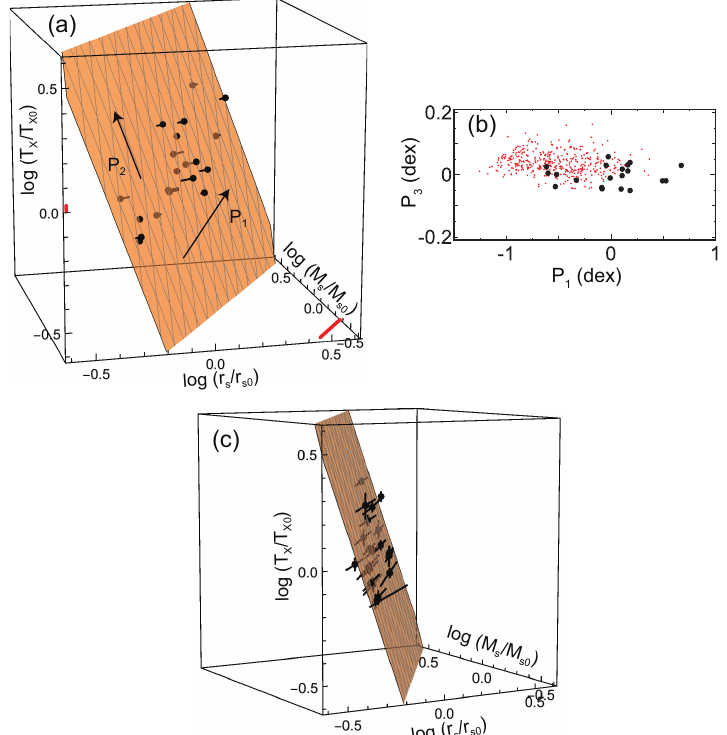
Figure 1. ( a ) Black dots (pin heads) are the CLASH data in the space of ( log ( r s / r s 0 ) , log ( M s / M s 0 ) , log ( T X / T X 0 )) , where r s 0 = 570 kpc, M s 0 = 3.8 × 10 14 M (cid:12) , and T X 0 = 8.2 keV are the sample geometric averages (log means) of r s , M s , and T X , respectively. The orange plane is the best fit of the data. The orange plane is translucent, and the grayish points are located below the plane. The lengths of the pins show the distance to the plane. The red bars show typical 1 σ errors of the data. The arrow P 1 shows the direction to which the data distribution is most extended, and the arrow P 2 is perpendicular to P 1 on the plane. ( b ) The cross-section of the plane in ( a ). The large black dots are the CLASH data, and the small red dots are the MUSIC results shown in Figure 3. The latter is projected on the P 1 – P 3 plane determined for the former. The direction P 3 is the plane normal. Note that the scales of the vertical and horizontal axes are different. ( c ) The same as ( a ) but error bars for individual clusters are included. The viewing angle is changed so that the relation between the error bars and the plane is easily seen (Figure is reconstructed from Figure 1 of